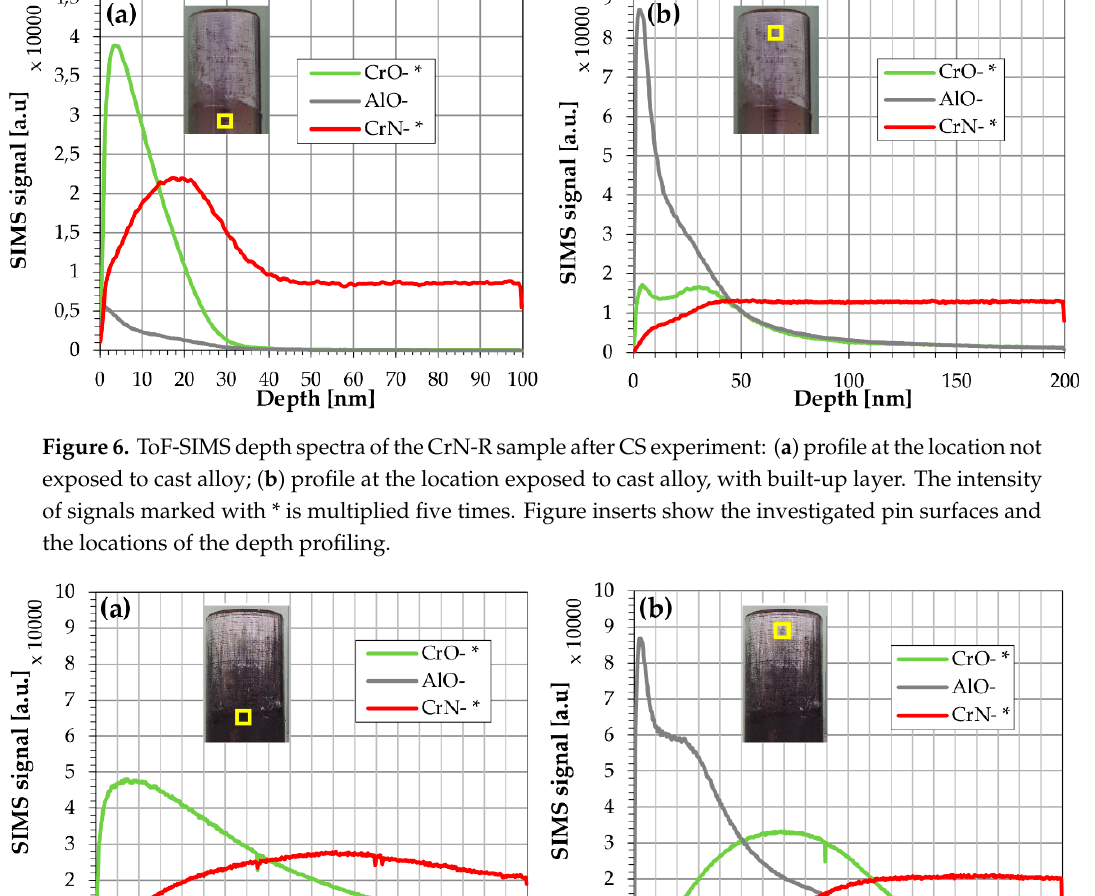
Figure 7. ToF-SIMS depth spectra of the CrN-R sample after DS 20 experiment: ( a ) profile at the Figure 7. ToF ‐ SIMS depth spectra of the CrN ‐ R sample after DS 20 experiment: ( a ) profile at the